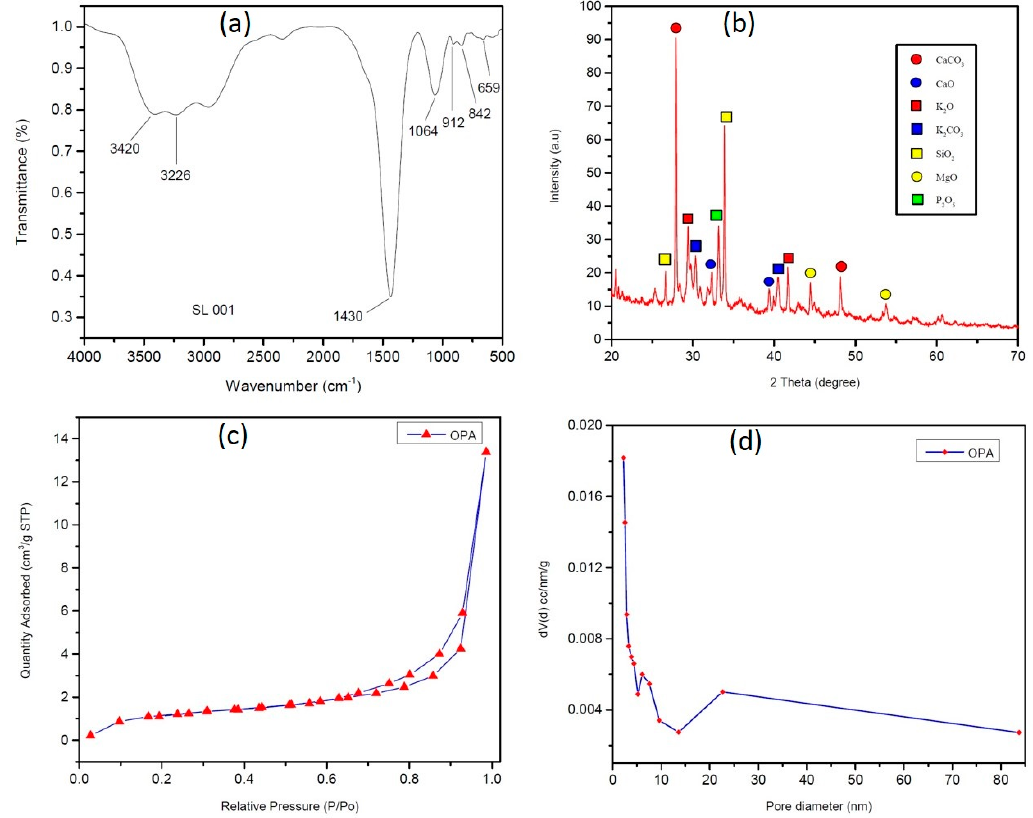
Figure 2. ( a ) FT ‐ IR spectra of OPA ( b ) XRD data of OPA, ( c ) N 2 adsorption–desorption isotherm, and ( d ) Barrett ‐ Joyner ‐ Halenda (BJH) pore size distribution analysis. Energy ‐ dispersive X ‐ ray spectroscopy (EDX) displayed the elemental composition of OPA catalyst (Figure 3a), indicating the presence of C, O, Mg, P, Cl, K and Ca. Table 2 shows the elemental distribution with weight % and atomic % in the catalyst.